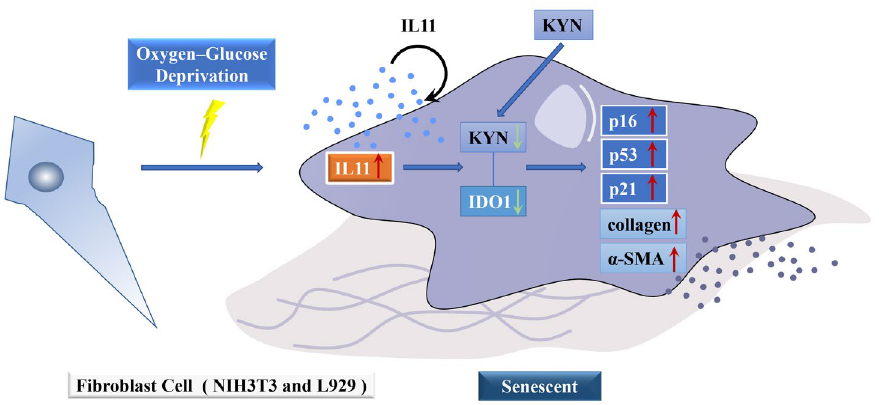
Figure 11. A schematic diagram of the mechanism by which OGD promotes senescence and collagen expression in fibroblasts. We found that OGD may promote fibroblast senescence and collagen expression through IL11 inhibition of the IDO1/KYN metabolic pathway.